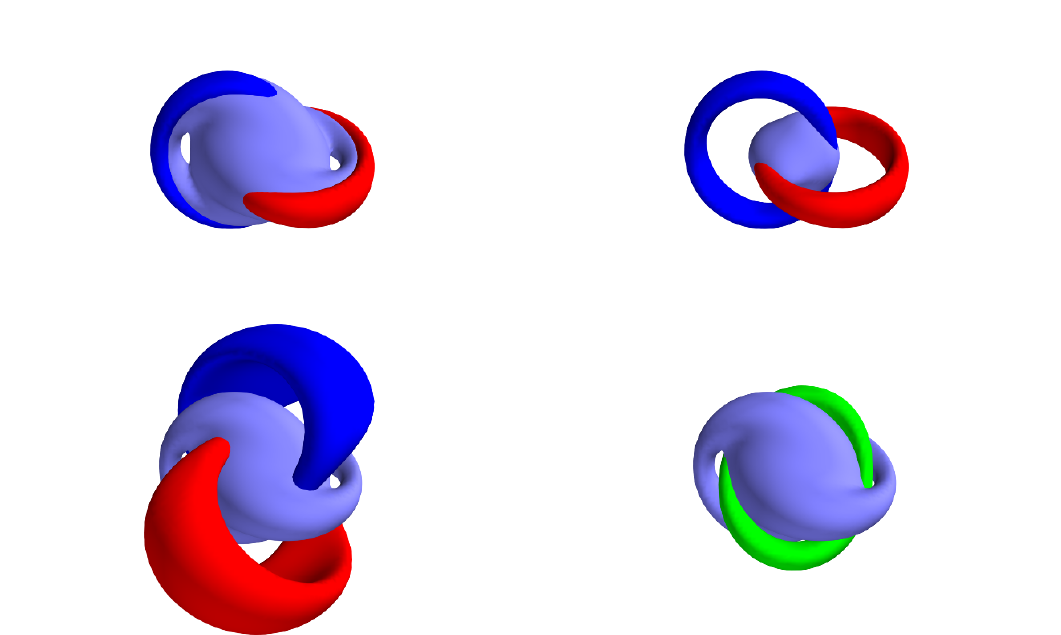
Figure 3 . Q = 1 Hop(cid:12)on solution at c 2 = 0 : 5 ; c 4 = 1 ; m = 4. Top row: isosurfaces of (cid:30) 1 = (cid:6) 0 : 9 together with the energy isosurface at E = 45 (left) and E = 100 (right). Bottom row: location curves of (cid:30) 2 = (cid:6) 0 : 9 (left) and (cid:30) 3 = (cid:0) 0 : 9 together with the energy isosurface at E =